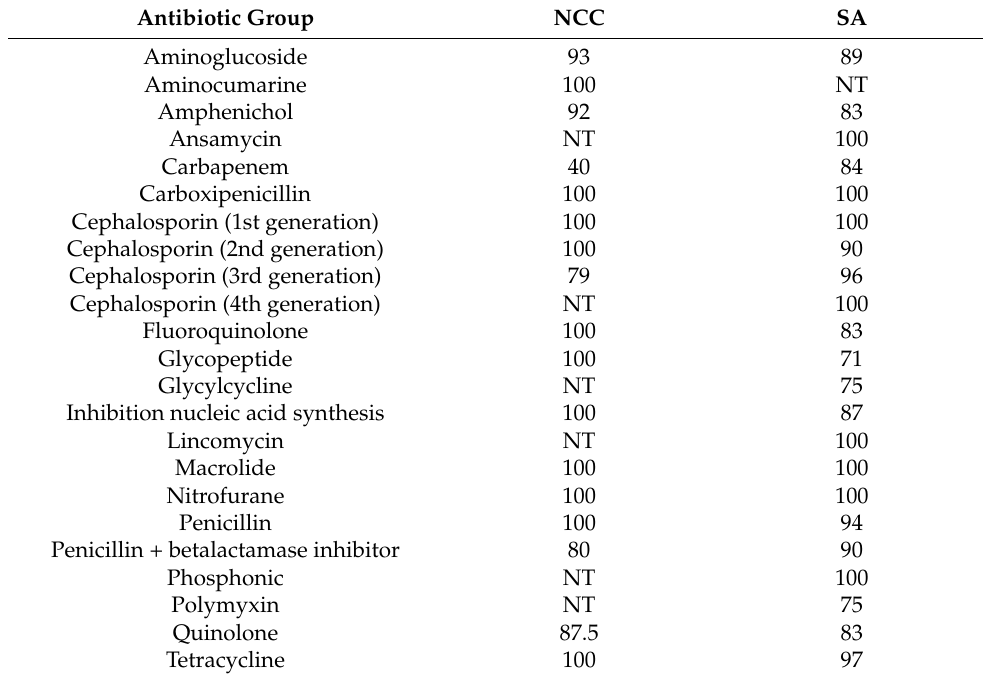
Table 1. Percentage of studies that reported antimicrobial resistance in aquatic environments, by region and antibiotic class. Antibiotic Group